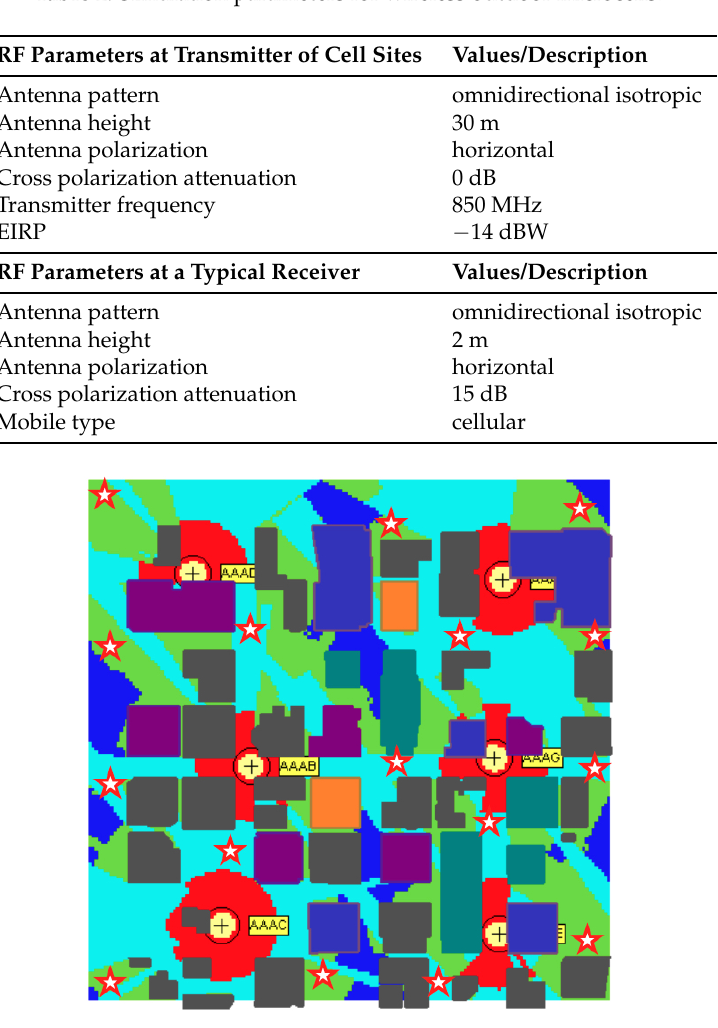
Table 2. Simulation parameters for wireless outdoor microcells.